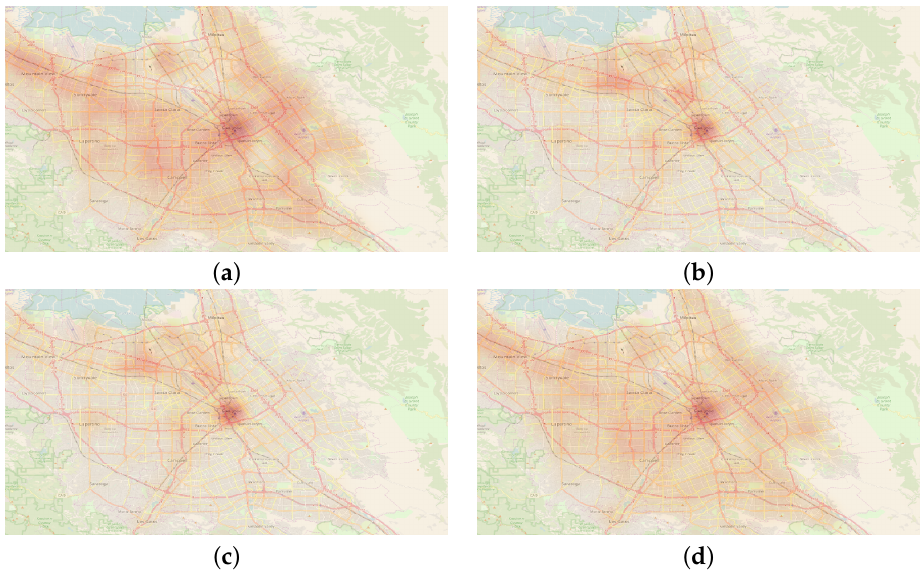
Figure 3. Heat Map of departures and arrivals by time of day. ( a ) Morning departures up to 12 p.m.; ( b ) Morning arrivals up to 12 p.m.; ( c ) Afternoon departures after 12 p.m.; ( d ) Afternoon arrivals after 12